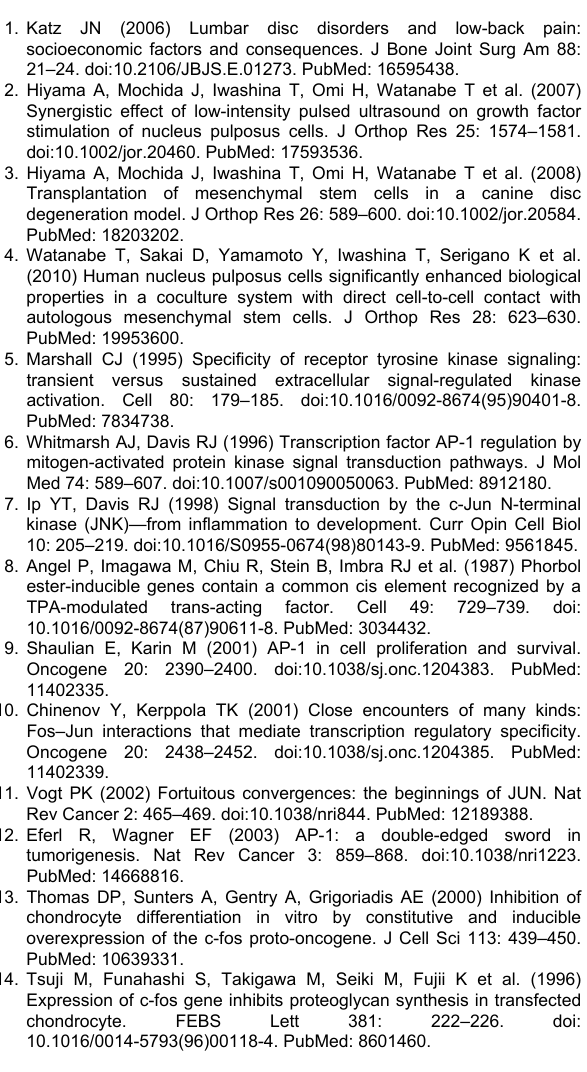
Figure S2. C-fos immunoreactivity in the sagittal sections of IVDs from 3-week-old rats. Immunohistochemical images of IVD from 3-week-old rats showed moderate levels of c-fos expression and vacuolated morphology. Membranous (arrow) and nuclear (arrowhead) staining can be observed (original magnification 2× or 20×).